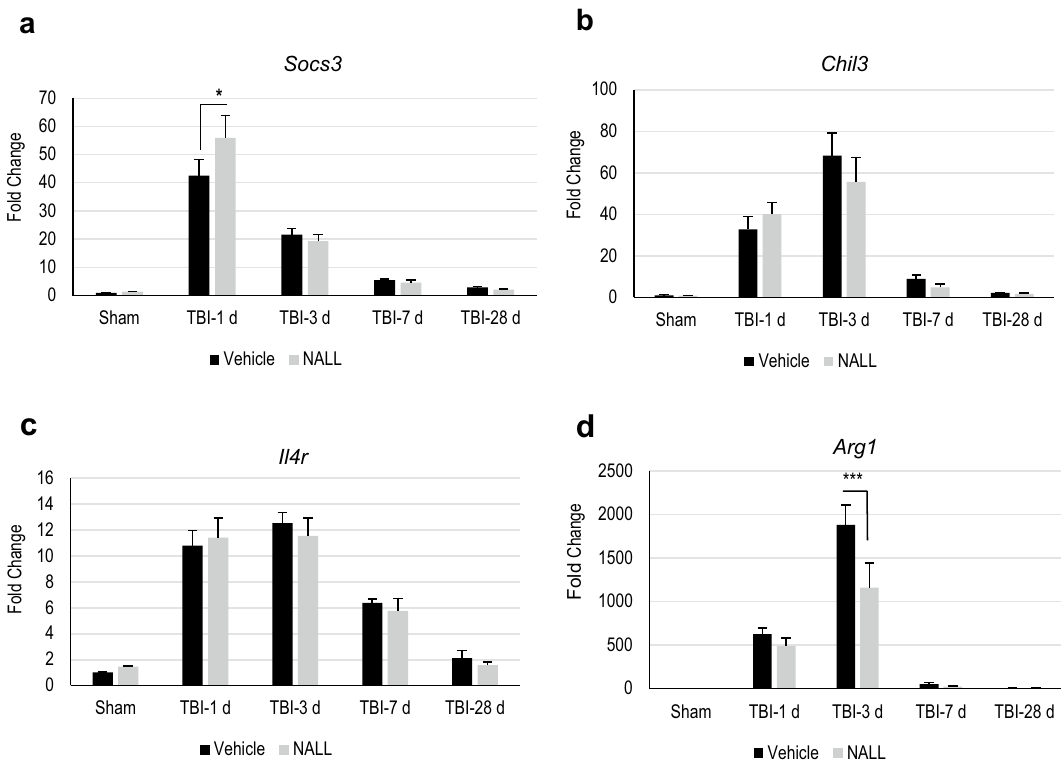
Figure 5. NALL alters the levels of anti-inflammatory markers in the injured mouse cortices. Relative mRNA levels of ( a ) SOCS3 ( Socs3 ), ( b ) YM-1 ( Chil3 ), ( c ) IL-4R ( Il4r ) and ( d ) Arginase ( Arg1 ) in the cortices of sham and TBI mice fed with NALL or vehicle. Data are presented as mean ± SEM. n = 5/group, ***p < 0.001, *p < 0.05 (Two-way ANOVA with Bonferroni